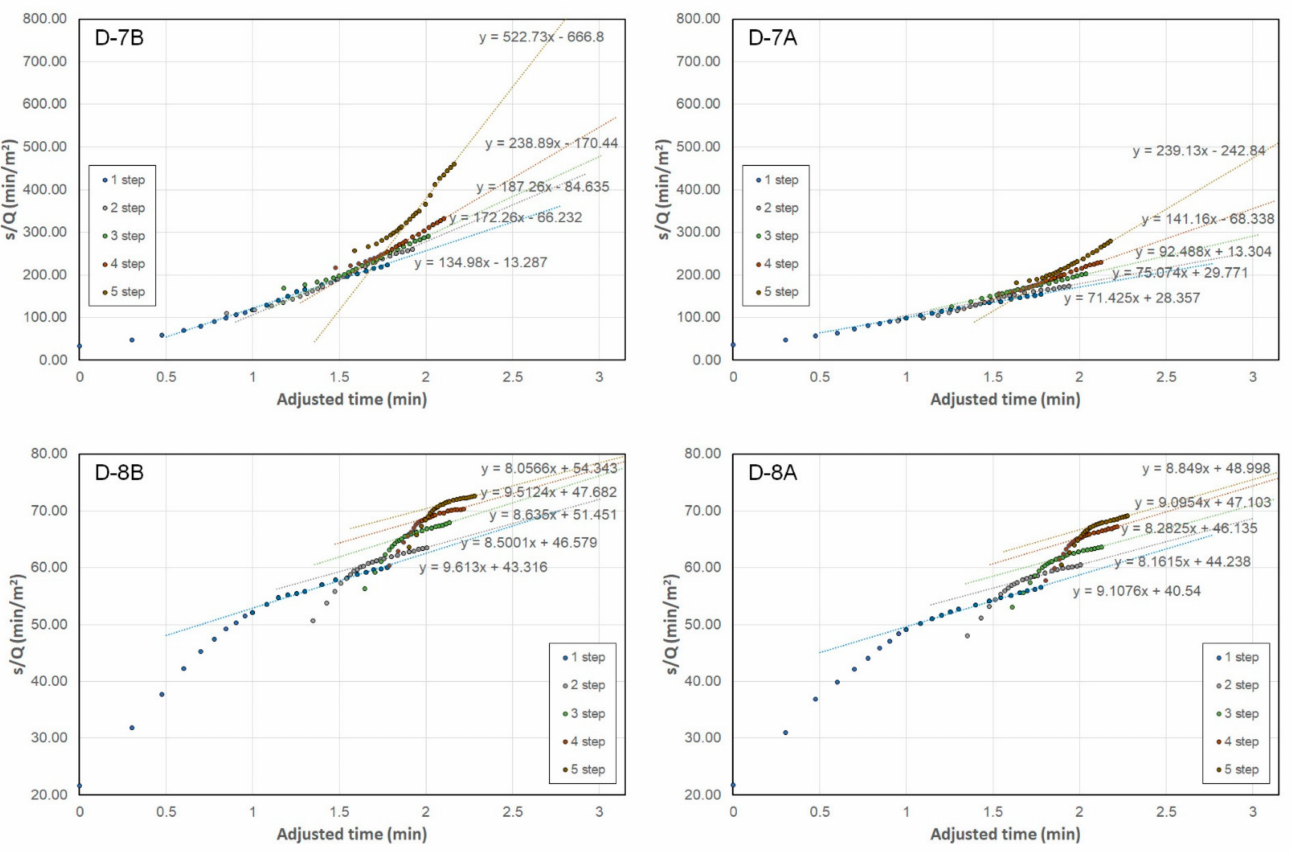
Figure 4. The relationship between specific drawdown and pumping rate before (D-8B, D-7B) and after (D-8A, D-7A) air surging. Curve fittings were made using the latter data for each pumping